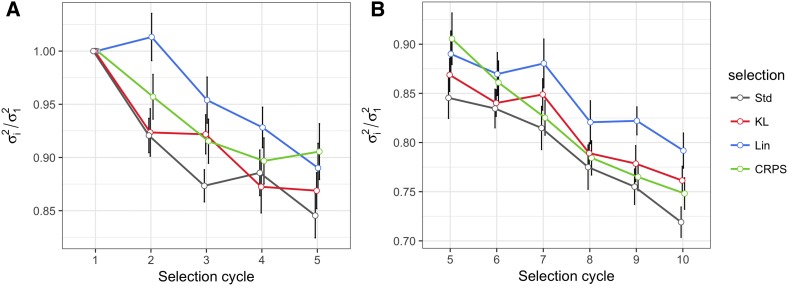
Results of the univariate simulation study. Scaled population variance (σi2/σ12) for breeding cycles 1 to 5 are illustrated in A), while in B) are cycles 5 to 10. In each selection cycle, the top 30% were selected using the Kullback-Leibler loss function (KL), the Continuous Ranked Probability Score (CRPS), the Linear-Linear loss function (LinLin), and lines selected under the standard method (Std). Selected lines were crossed at each cycle to recover the population size for the upcoming selection cycles. σi2 and σ12 are the population variance in cycle i and cycle 1, respectively. The black vertical lines indicate the standard error of σi2/σ12 under 20 replications of the simulation study.